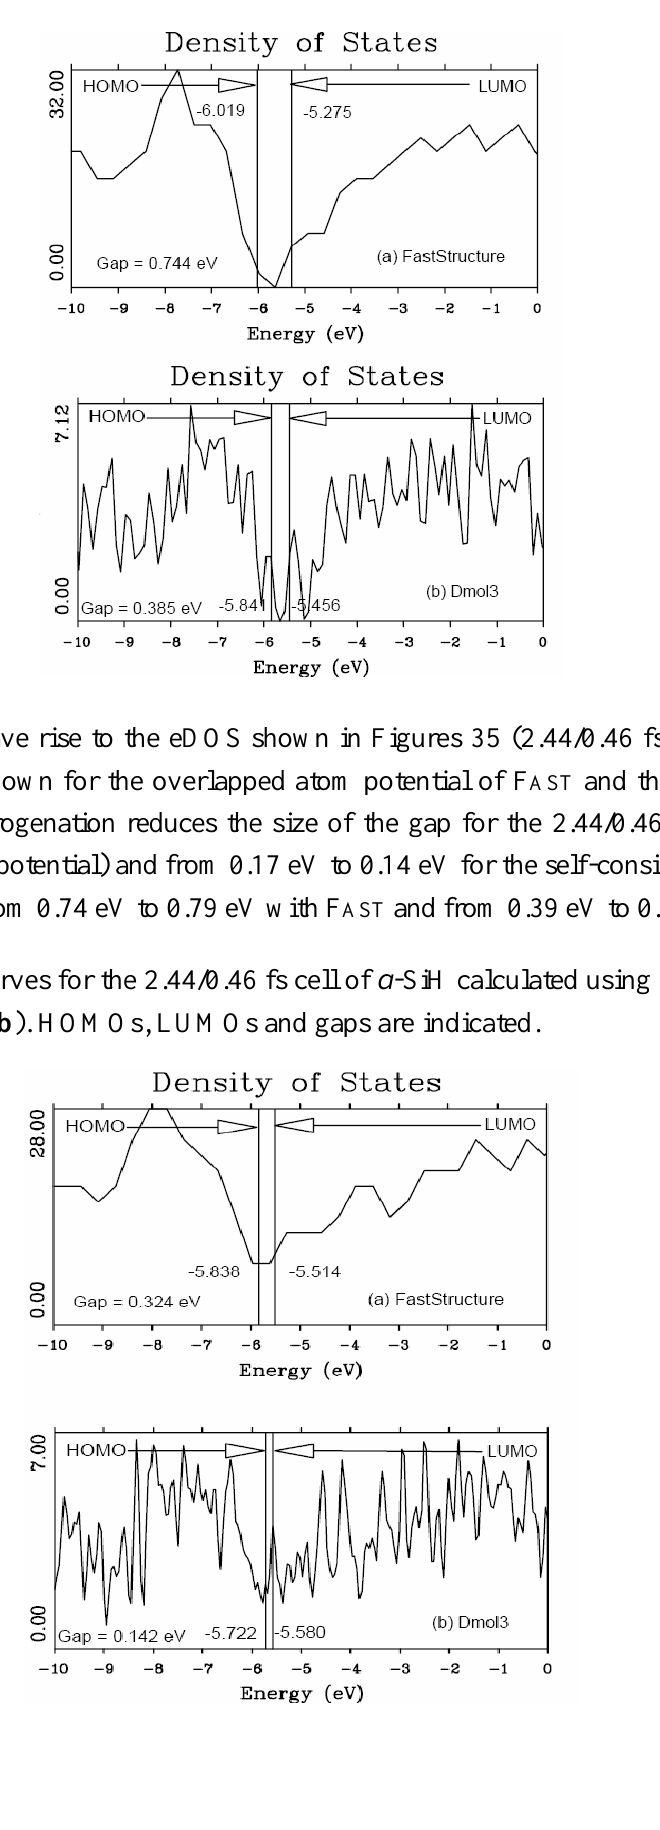
Figure 34. eDOS curves for the 10 fs cell of a -Si calculated using F AST , curve ( a ), and DM OL 3, curve ( b ). HOMOs, LUMOs and gaps are indicated.